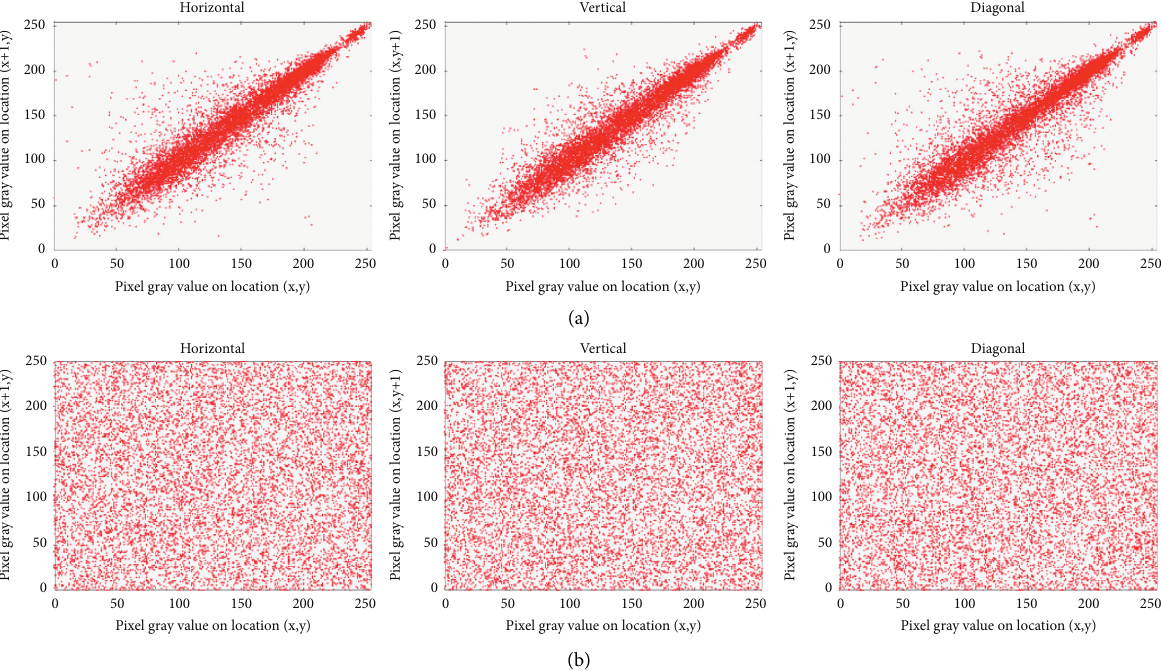
Figure 6: Correlation distribution for red component of plain composite image in Figure 4(a) (a) and those from the cipher composite image in Figure 4(b) (b).